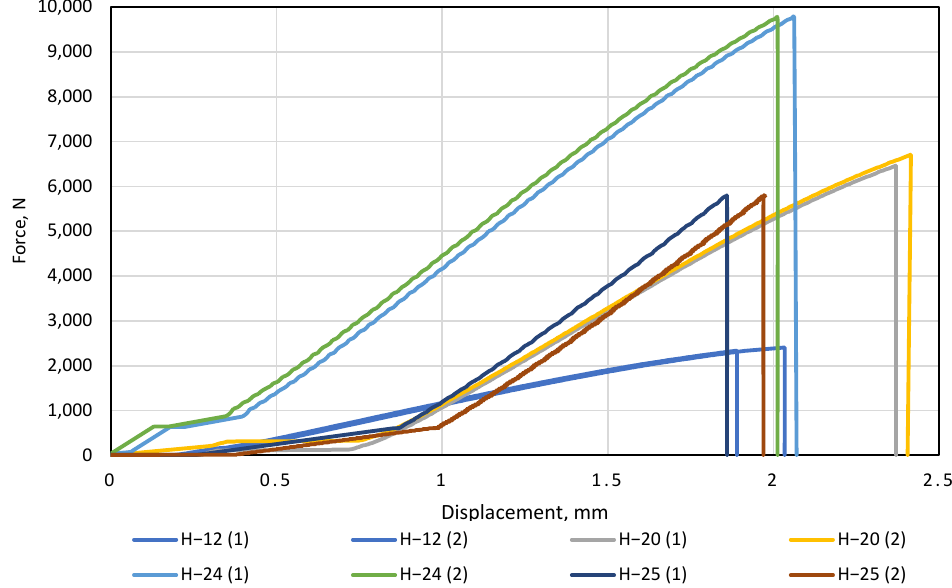
Figure 10. Load and displacement curves of glued specimens.